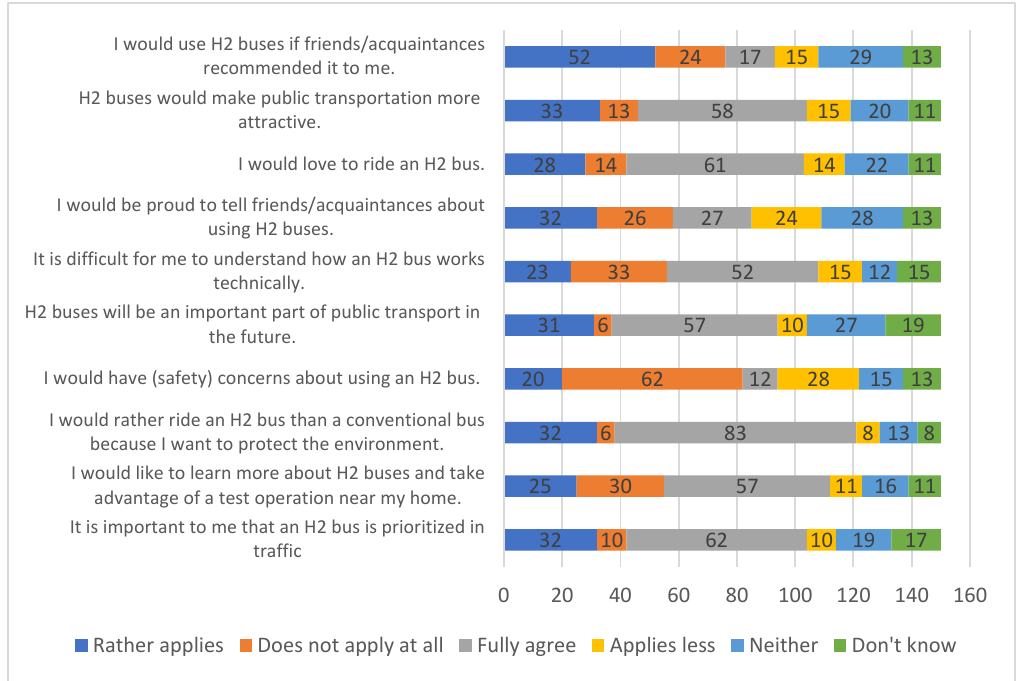
Figure 4. Result of questionnaire about Offenburg citizen’s acceptance with hydrogen bus .